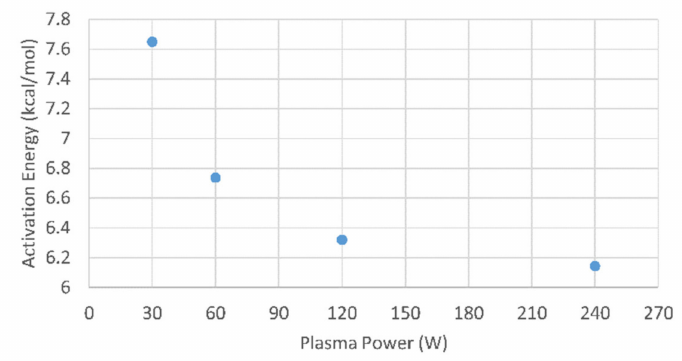
Figure 3. The effective activation energy for PECVD boron films as function of plasma power. Generally, in plasma systems an increasing pressure leads to a lower plasma ion den- sity, which causes effectively less energy to be supplied to the precursor molecules [67,68]. Based on this, the effective activation energy is expected to increase for increasing pressures. This trend is confirmed by our data shown in Figure 4.